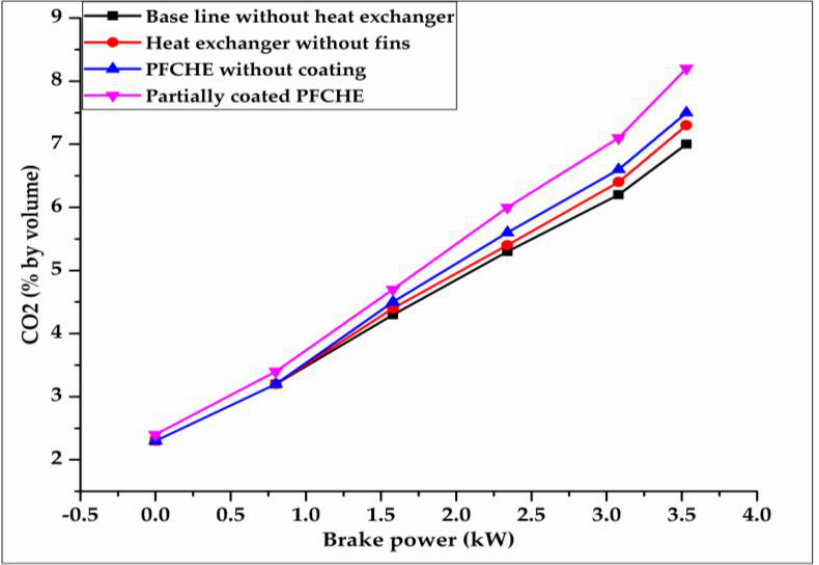
Figure 12. Effect of heat exchanger on CO 2 emission.